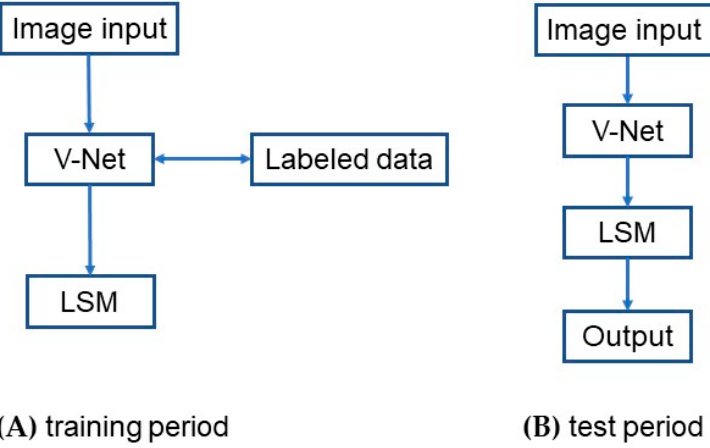
Figure 2. The structure of the VLSM-Net model: ( A ) training period; ( B ) test period.